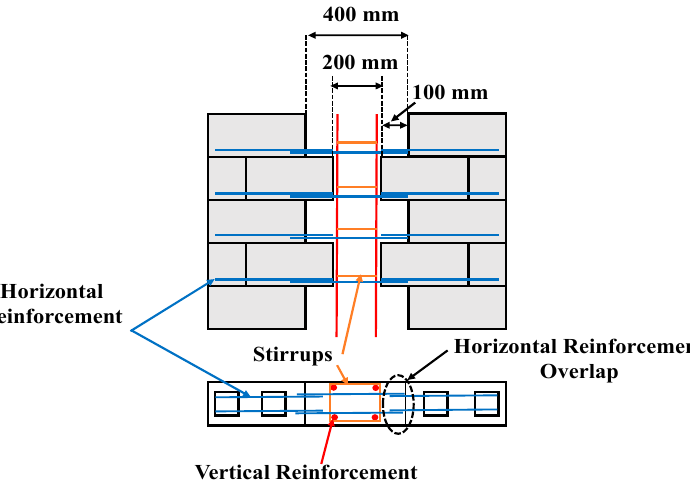
Figure 4. Proposed vertical joints for prefabricated RM walls by Zhang et al. [47]